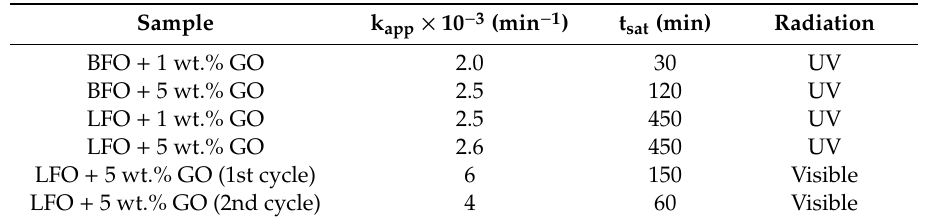
Table 1. k app and t sat of the BFO / rGO and LFO / rGO composite layers under UV or visible light